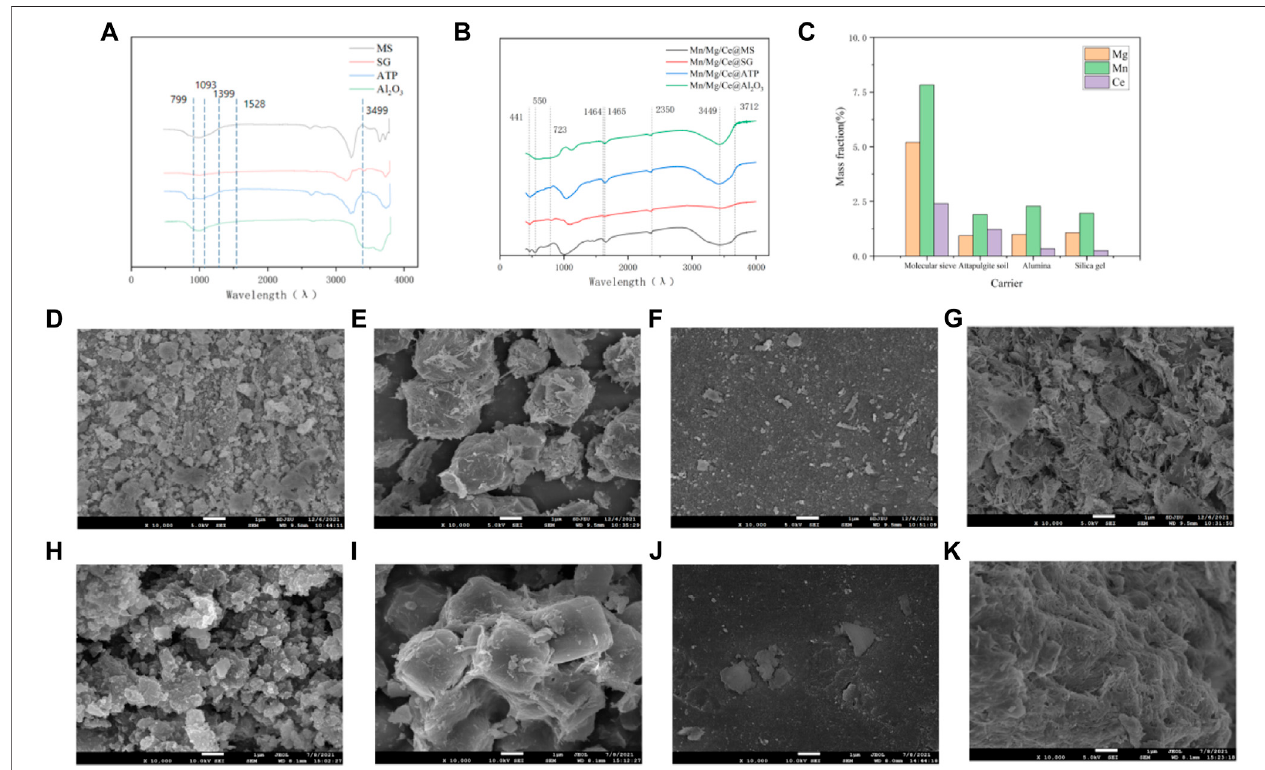
FIGURE 1 | (A) FTIR spectra of the four carriers. (B) FTIR spectra of the four catalysts. (C) Mass fractions of the target elements loaded by the four carriers. SEM images of (D) Al 2 O 3 , (E) MS, (F) SG, and (G) ATP. (H) Mn/Mg/Ce@Al 2 O 3 , (I) Mn/Mg/Ce@MS, (J) Mn/Mg/Ce@SG, (K)